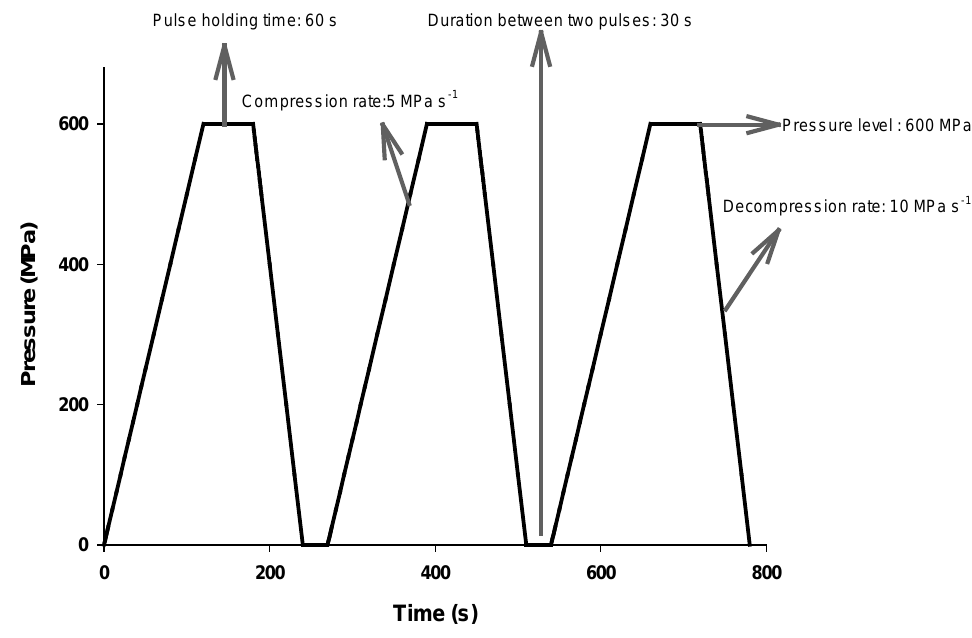
Figure 2. Multi-pulsed HHP treatment: 3 pulses × 60 s (30 s between each pulse) at 600 MPa. Compression and decompression rates are 5 and 10 MPa·s −1 , respectively. Note that total duration of the treatment is 780 s (13